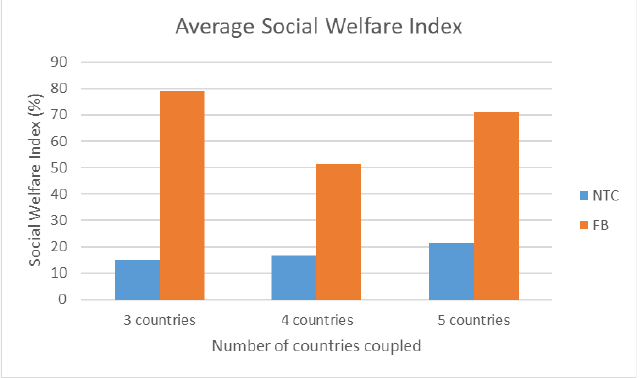
Figure 7. Average social welfare index via both approaches.